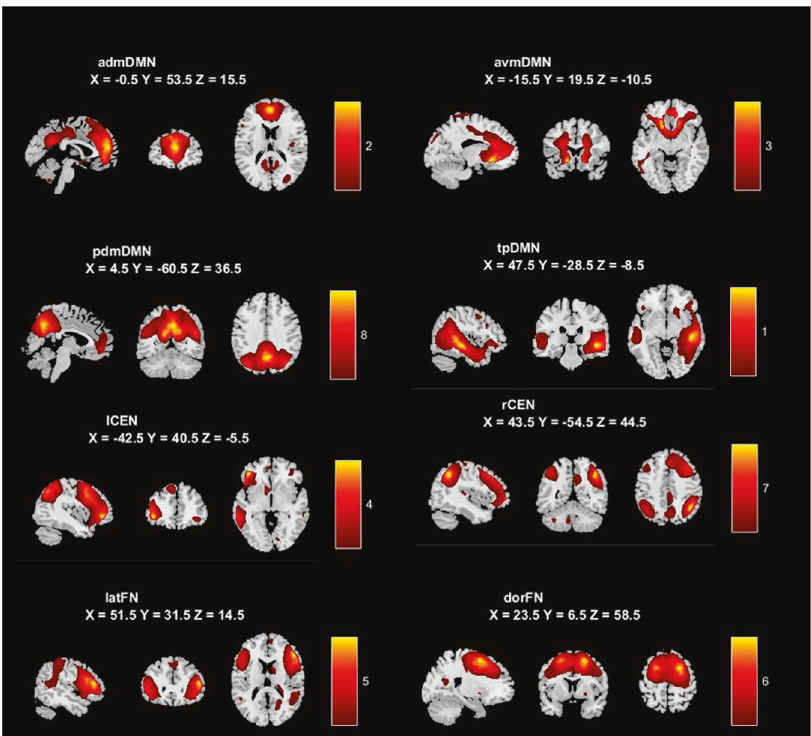
Fig. 1 Eight chosen networks of interest from ICA analysis. MNI coordinates are provided for the slices presented. admDMN anterior dorsomedial default mode network, avmDMN anterior ventromedial default mode network, pdmDMN posterior dorsomedial default mode network, tpDMN temporoparietal default mode network, lCEN left central executive network, rCEN right central executive network, latFN lateral frontal network, dorFN dorsal frontal